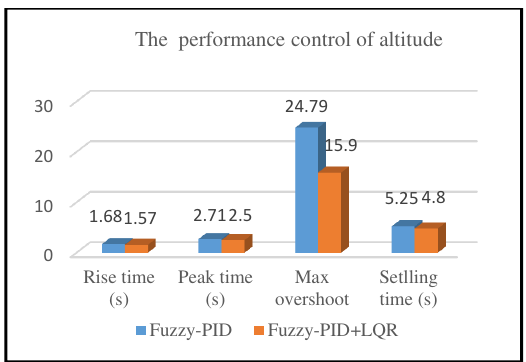
Fig . 12. Altitude change when elevator change.